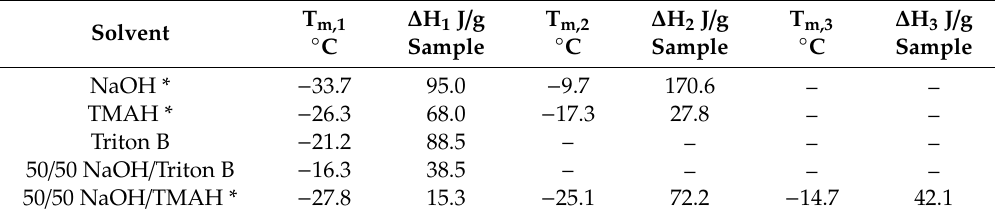
∆ H / g T m,1 1 J ◦ C Sample